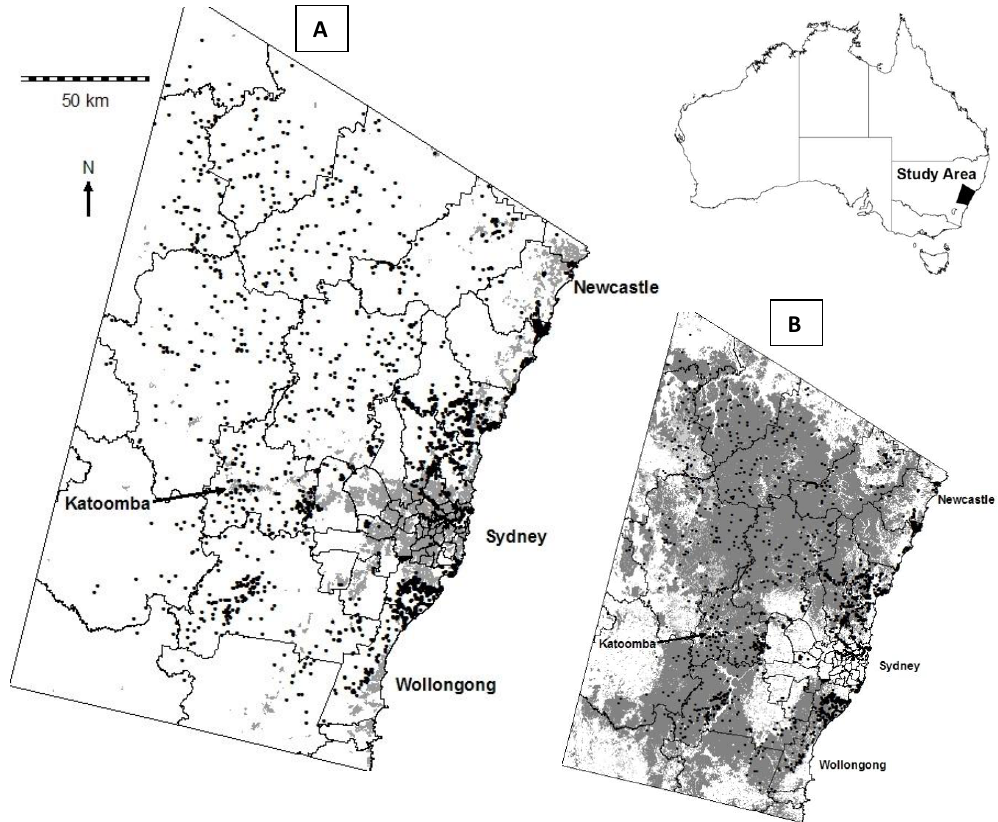
Fig. 1. The study area, showing (A) the ignition points of all fires and the defined urban land (grey shading) and (B) forested vegetation surrounding Sydney (grey shading) (Office of Environment and Heritage, unpublished data